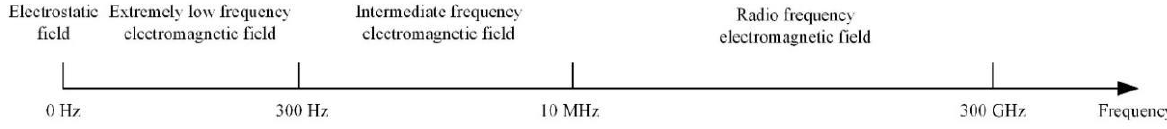
Figure 1. The frequency band of the electromagnetic field.